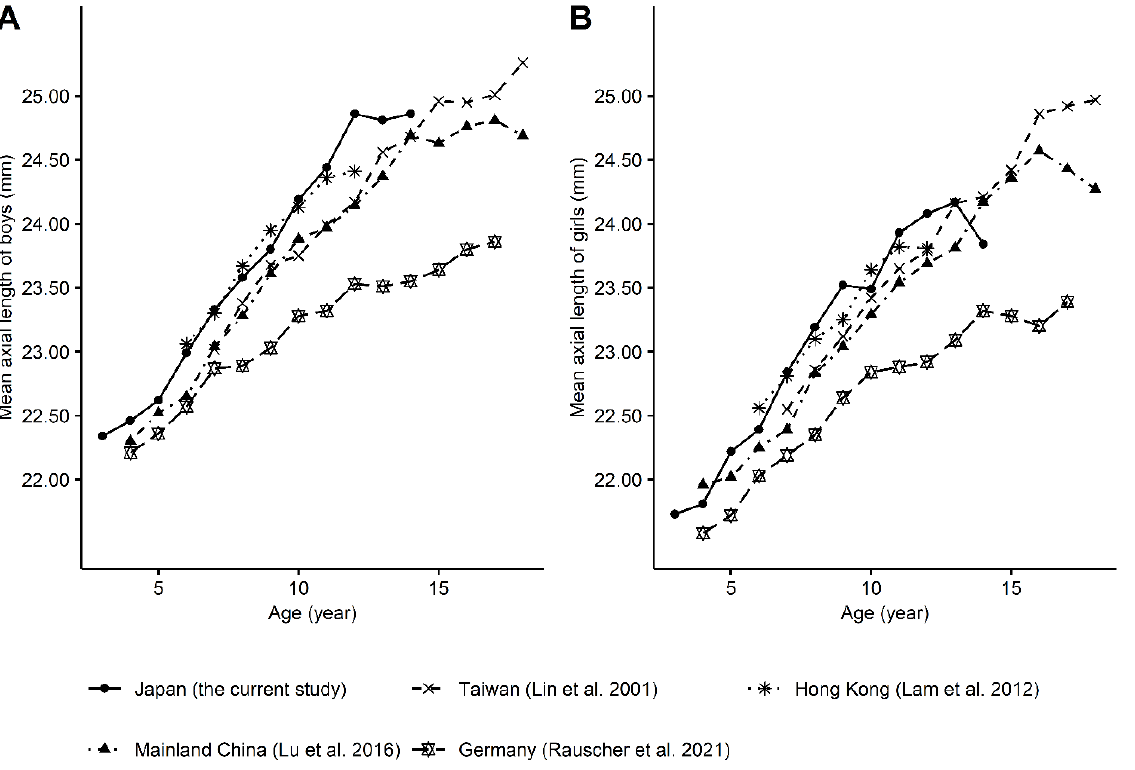
Figure 3. Sex- and age-specific distribution of the mean axial length (AL) from the current study and other school-based cross-sectional studies [7–10]. The mean ALs as a function of age are plotted for, ( A ), boys and, ( B ), girls using data from the current study and other school-based cross-sectional studies. For AL measurements, A-scan ultrasonography was used in the Taiwanese study, and optical biometry was used in the other studies.